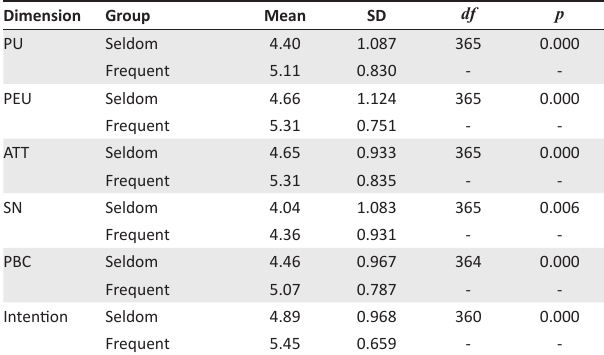
TABLE 3: Differences between frequent and seldom users of Uber. Dimension Group